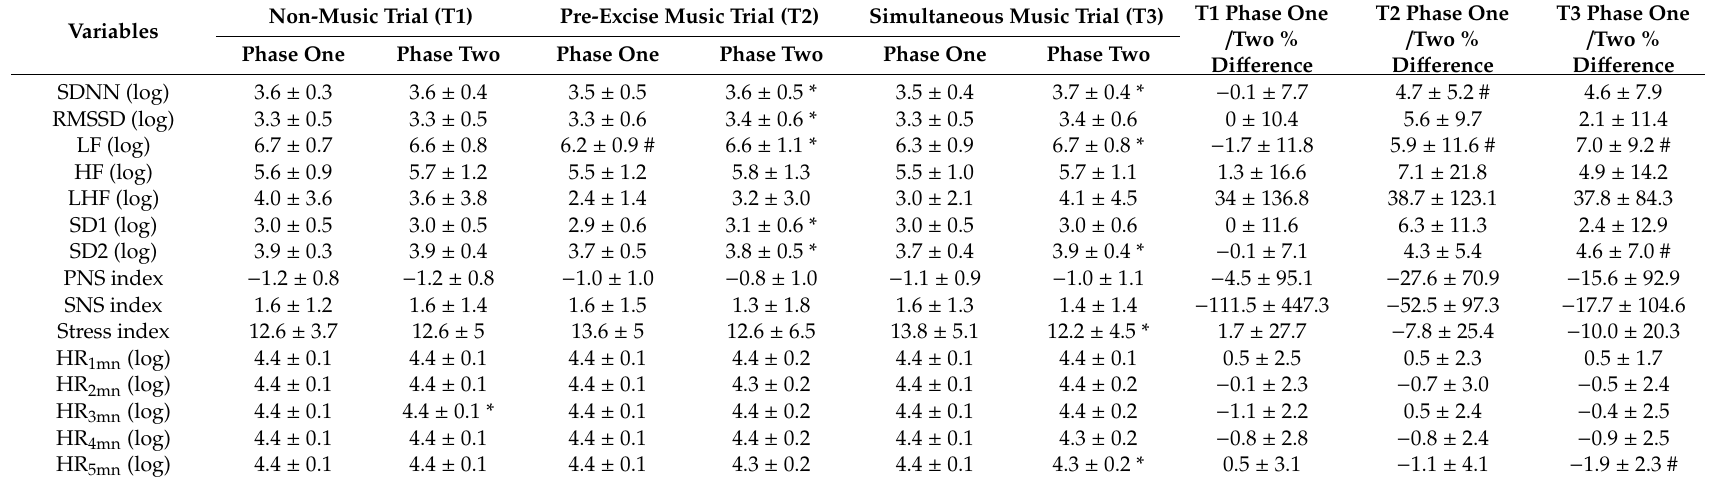
Table 3. Descriptions of heart rate and heart rate variability in non-music, pre-exercise music, and simultaneous music